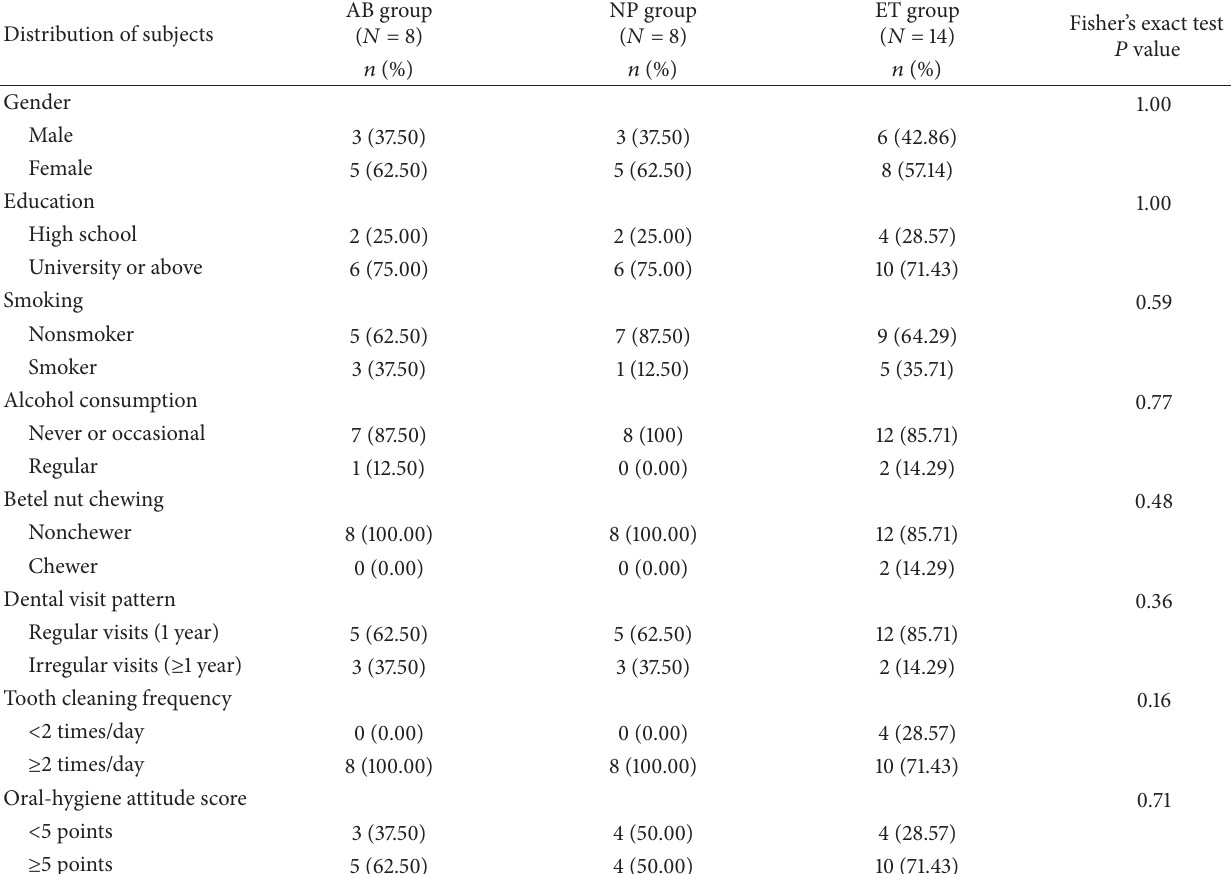
Table 1: Demographic characteristics, oral-health behaviors, and oral-hygiene attitude scores of study subjects.